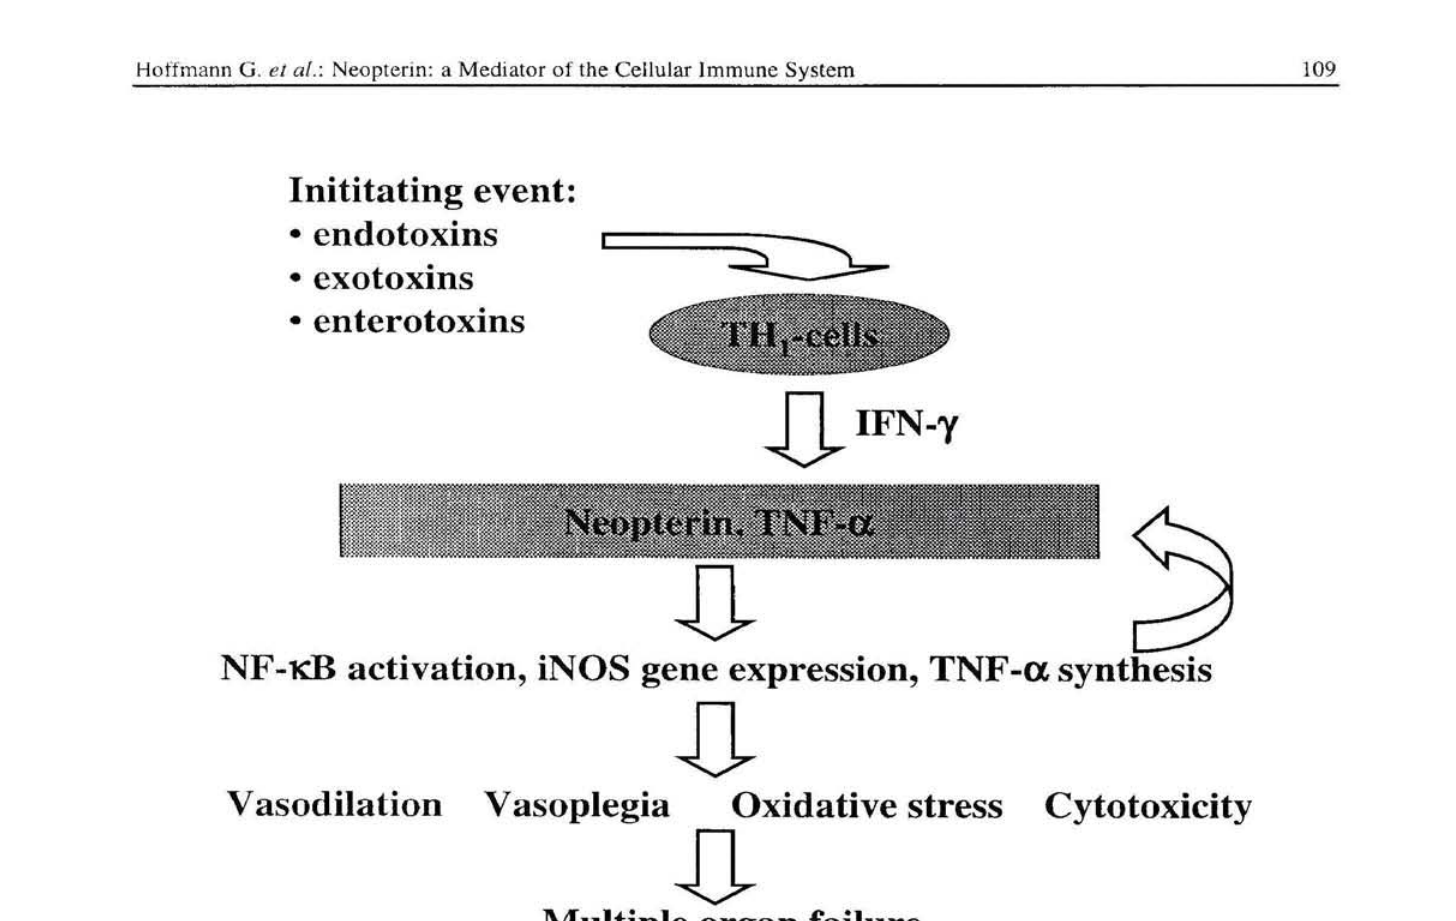
Figure 3. Potential role of neopterin in the pathogenesis of sepsis and septic shock. Bacterial infections lead to the activation of T H l - t y pe lymphocytes. The ensuing release